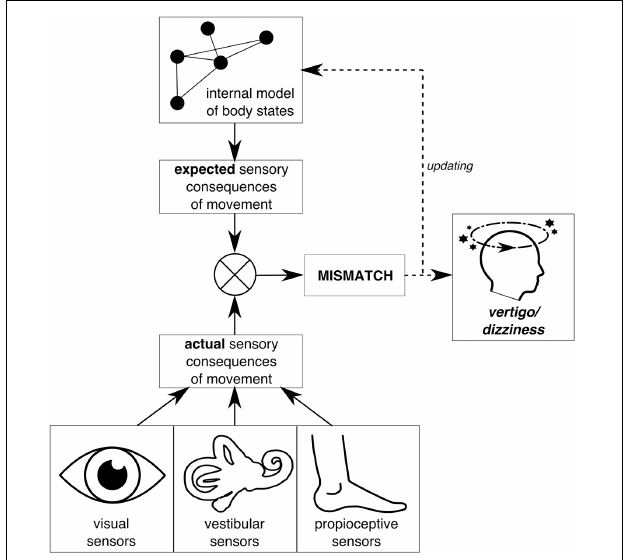
FIGURE 1 | Schematic illustration of symptom emergence in the predictive coding framework on the example of vertigo/dizziness. Predictive coding understands perception as a constant interplay between incoming sensory information and internal expectations about such sensory input. In balance perception, for example, the actual sensory consequences of movement are processed by the visual, vestibular, and proprioceptive systems. Expectations about sensory consequences of movement are derived from internal models about the world and the body that constitute central nervous system (CNS)-internal representations of previously learned or experienced causal relations within the body, the environment, and their interaction. Ideally, such internal models match reality; i.e., they are a valid and reliable representation of the true causal relations. If this is not the case, resulting expectations about sensory input do not match the actual sensory activation. This mismatch, if not used as error signal to update internal models, can lead to persistent symptom experience, i.e.,